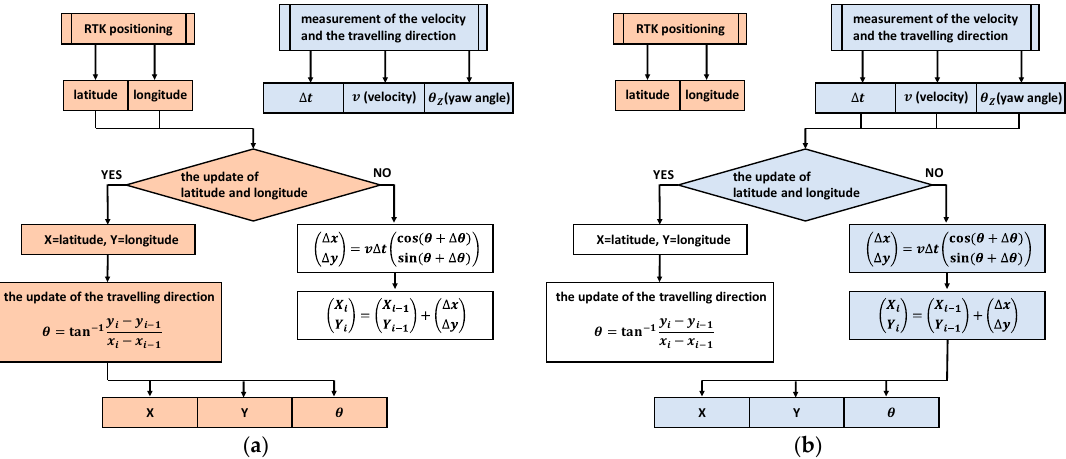
Figure 3. ( a ) The flowchart when the RTK positioning is completed; ( b ) The flowchart while the RTK positioning is not completed and the complementary system